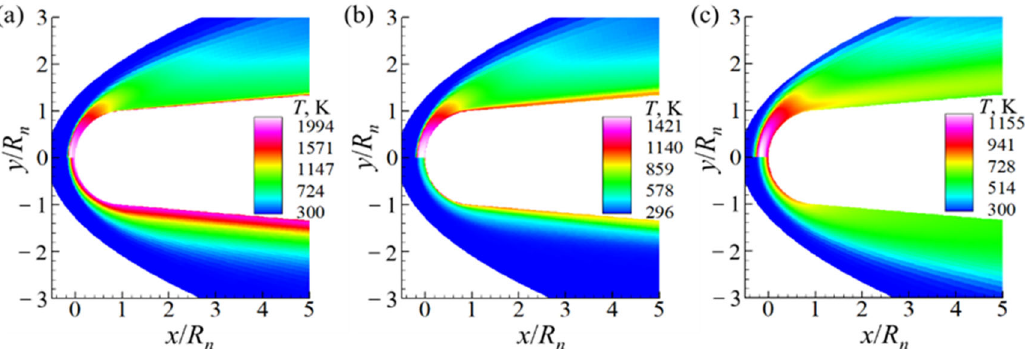
Figure 6. Contours of translational–rotational temperature and vibration–electron temperature at ( a ) 10 km, ( b ) 30 km, and ( c ) 60 km.